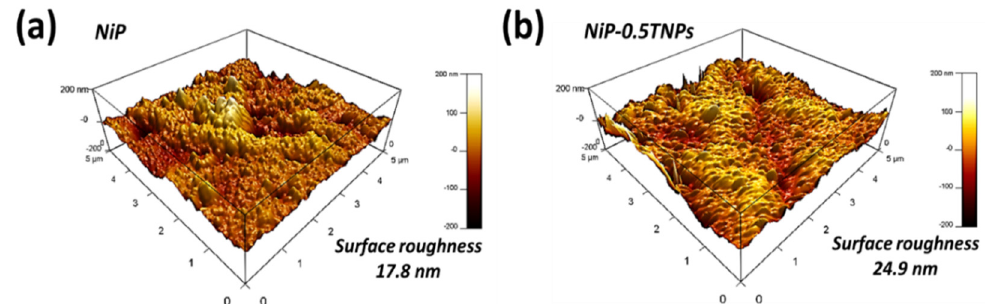
Figure 11. SEM micrographs of ( a ) NiP and ( b ) NiP-0.5TNPs composite coatings after heat treatment Figure 12. The 3D Surface topographic images for NiP ( a ) and NiP-0.5TNPs ( b ) coatings of 50 h heat treatment in an open furnace condition. for 50 h in air. Table 7. Comparison of the roughness parameters for NiP and NiP-0.5TNPs nanocomposite coating after 50 h heat treatment in an open furnace condition.